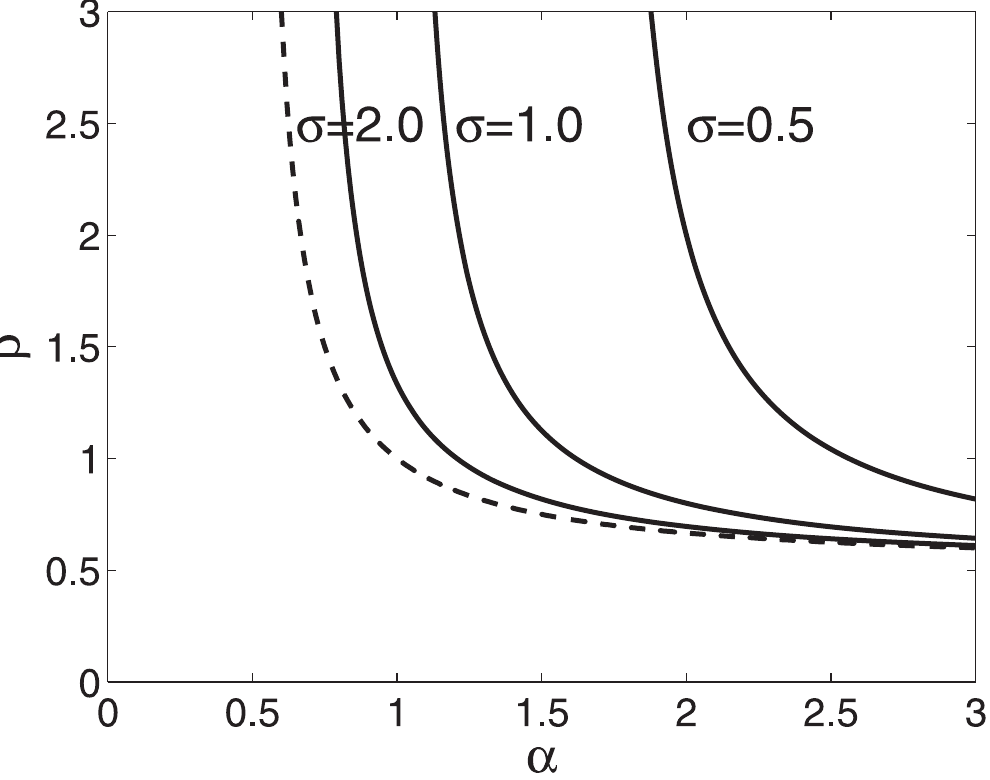
Figure 4. Conditions for local stability of an equilibrium with no gene supression ( x ~~ y ~~ 0 ) and optimum value of major locus effects ( X ~~ Y ~~ a == ( a zz b ) ) when the colony size is very large ( S ? ? ) for 3 different values of s (shown on the graph). The equilibrium is stable for a and b values on the left of the corresponding curve. The dashed curve corresponds to no costs of gene supression ( s ? ? ).